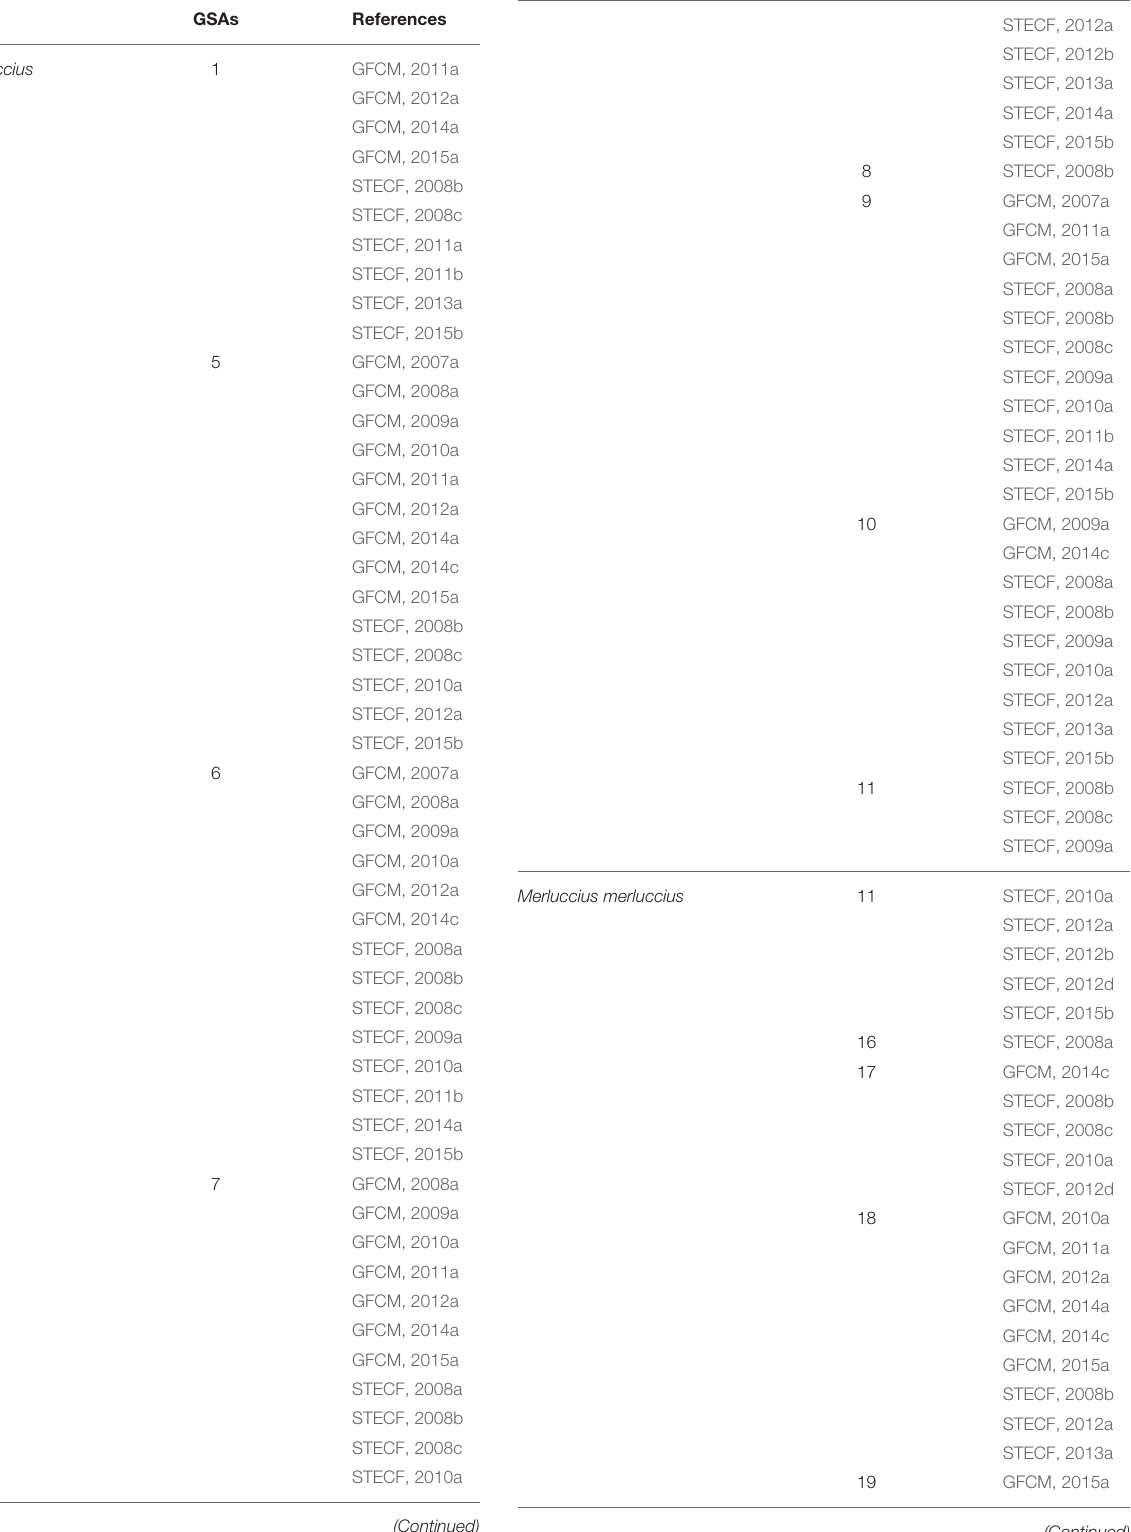
TABLE 1 | List of species and stocks (by GSA or combination of GSAs) collated in this study with the associated reference where the stock assessment has been